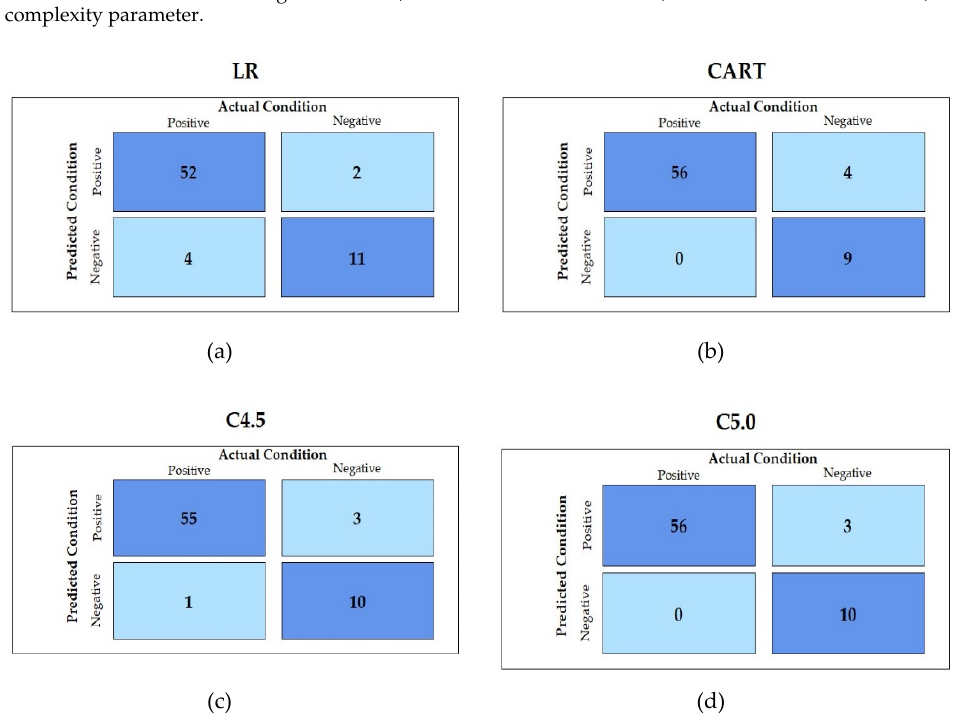
Figure 3. Confusion matrix of each method based on its best model: ( a ) LR; ( b ) CART; ( c ) C4.5; ( d ) C5.0.